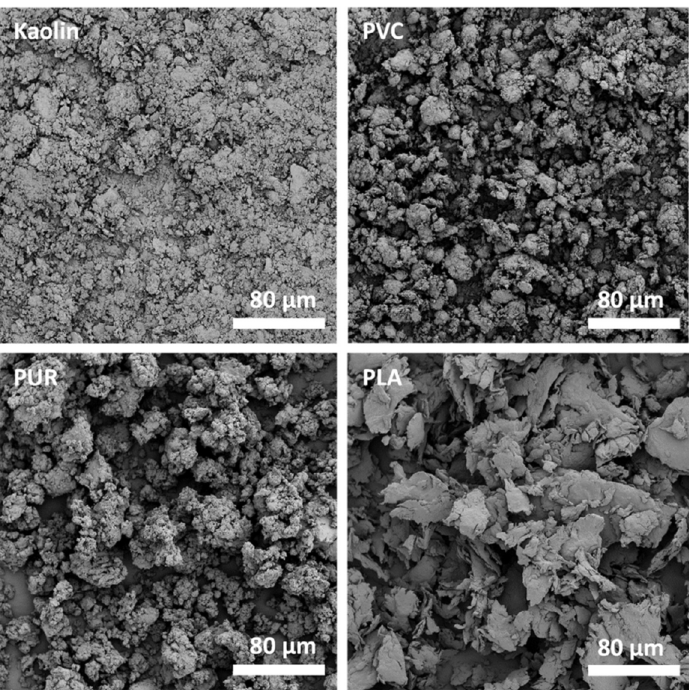
Figure 5. Particles of kaolin, PVC, PUR, and PLA generated with a ball mill, Reprinted with permission from ref. [165], Copyright 2021 Elsevier.